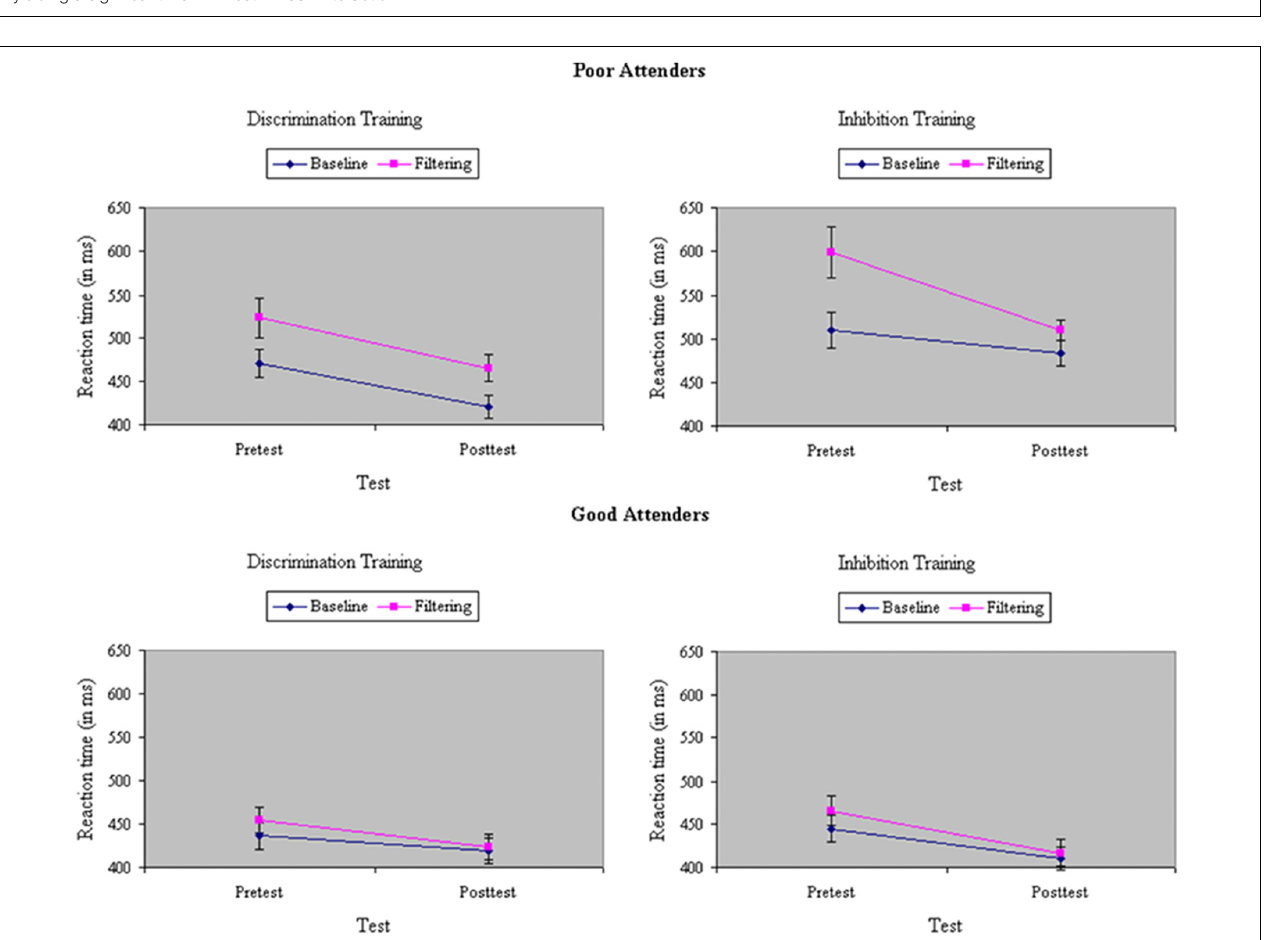
FIGURE 4 | Reaction time (in ms) in baseline and filtering tasks at pretest and posttest in discrimination and inhibition training groups, separately by poor attenders (Top) and good attenders (Bottom). Reductions in Garner RT interference from inhibition training were restricted to participants showing relatively poor selective attention at pretest, yielding a significant Skill × Train × Test × Task